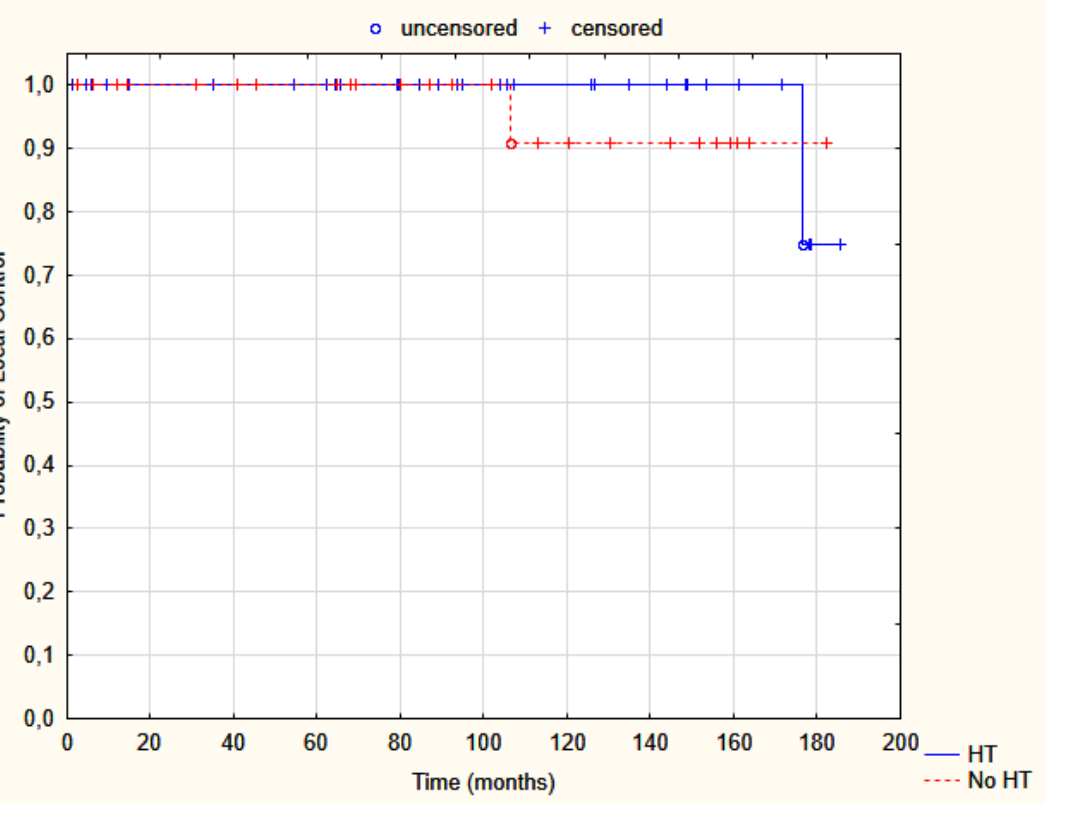
Figure 2. Probability of disease-free survival in group A, HDR-BT (red dotted line), and B, HDR-BT + thermal boost (solid blue line); Test log-rank, p = 0.98. HT—hyperthermia.